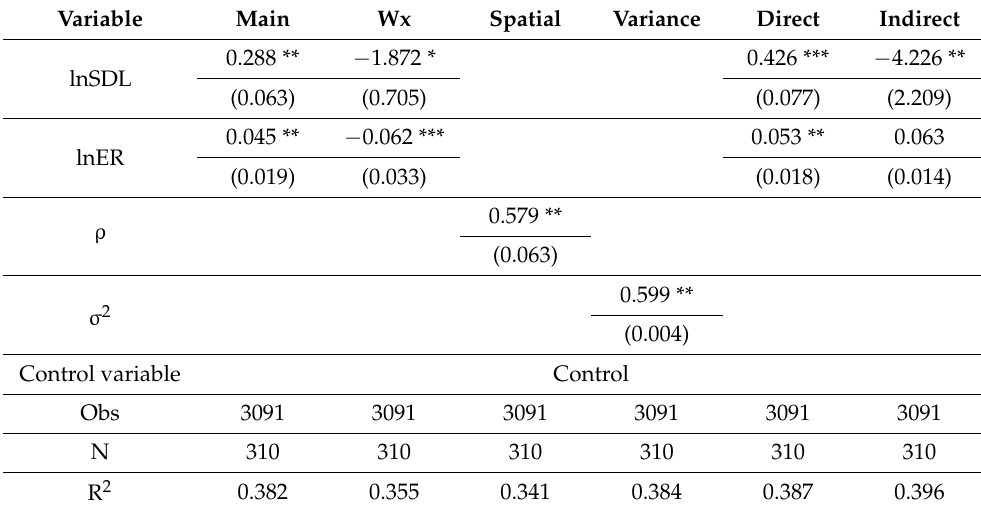
Table 7. Results of spatial model regression and spatial effect